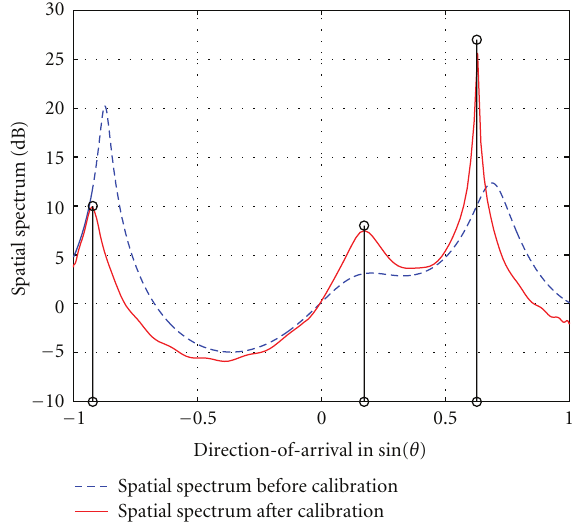
Figure 6: MUSIC spatial spectra obtained before and after the pro- posed joint gain/phase and mutual coupling